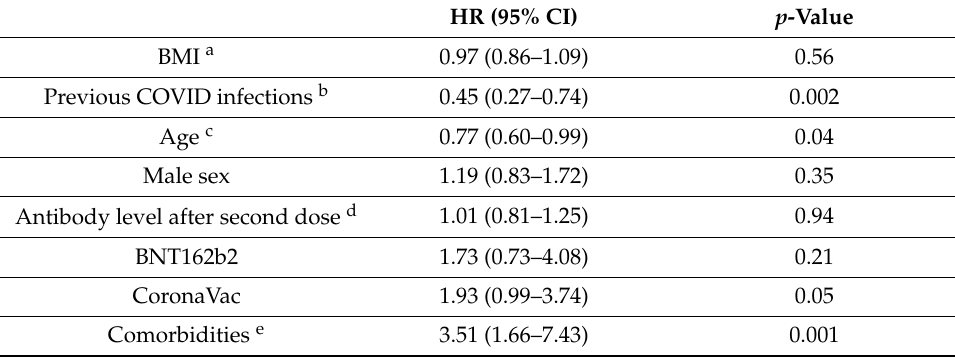
Table 5. Adjusted Cox Proportional Hazard